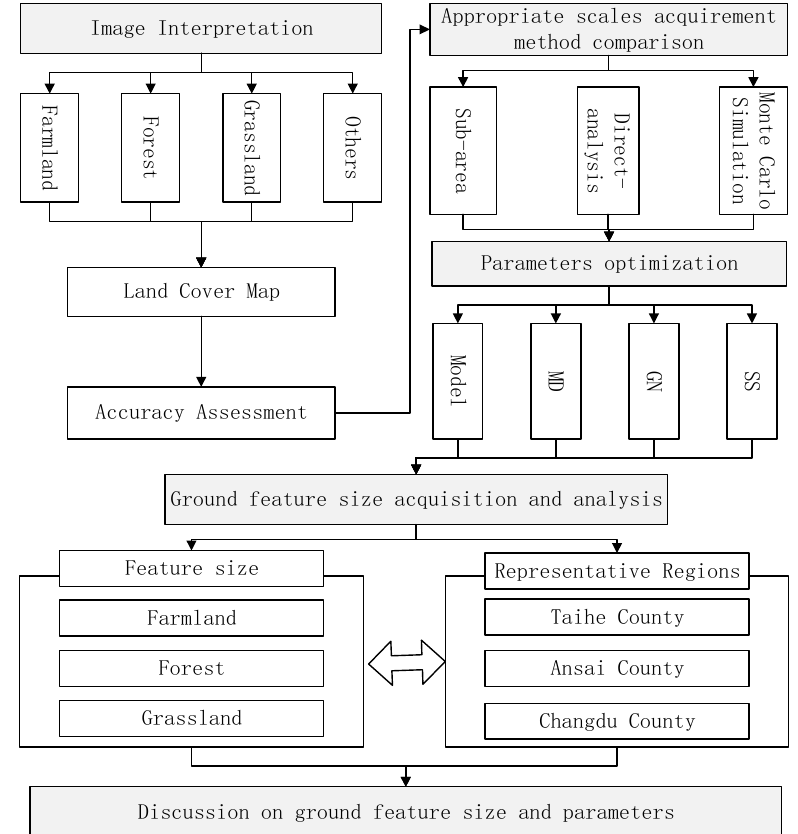
Figure 3. Workflow of this study.